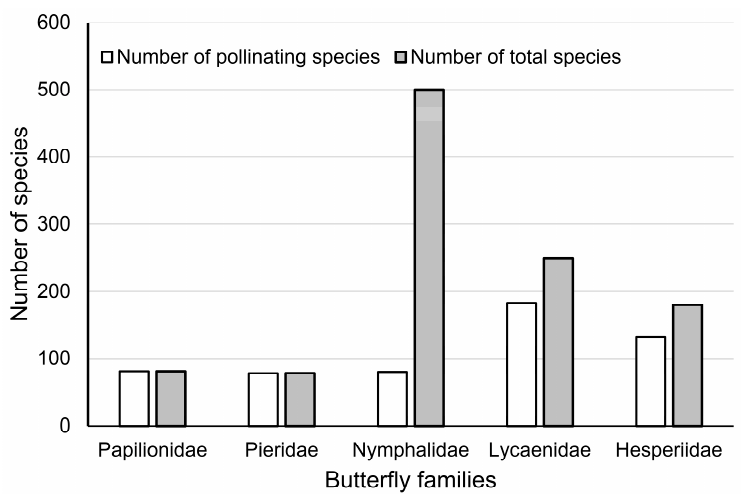
Figure 2. Statistics of pollinating butterflies in five families in comparison to the total number of butterflies in those